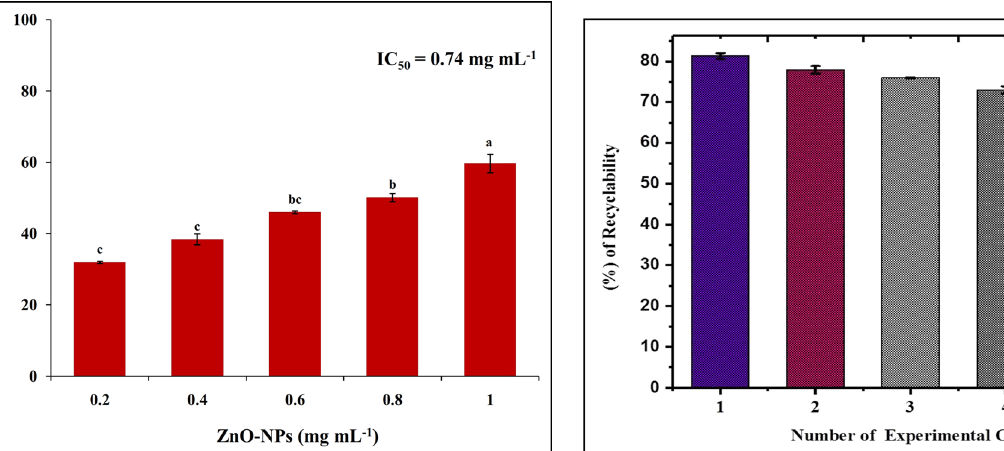
Figure 11: Antioxidant potentiality of phyto - fabricated ZnO NPs from S. acuta .